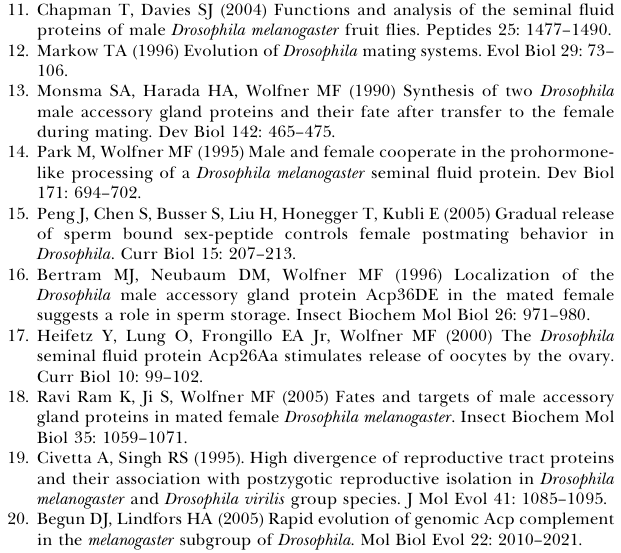
Figure S1. RT-PCR of (A) DmojGLEANR_8528, (B) Protease Gene Family 1, (C) Protease Gene Family 2, and (D) Protease Gene Family 3 One-kilobase markers are indicated. L, DNA ladder; N, negative control; M, whole male cDNA; C, female carcass (no lower reproductive tract) cDNA; R, lower female reproductive tract cDNA. Found at doi:10.1371/journal.pgen.0030148.sg001 (7.8 MB TIF). Table S1. D. arizonae Female Reproductive Tract ESTs D. mojavensis CDS: coding sequence from GLEANR annotations (http:// rana.lbl.gov/), D. melanogaster homolog identified by BLAST. SignalP: S, secreted; A, anchor; Q, quiescent as predicted by SignalP 3.0 [56]; TMHMM, number of identified transmembrane domains [57]; Ka, estimated nonsynonymous substitutions per nonsynonymous site; Ks, estimated synonymous substitutions per synonymous site; Ka/Ks, estimated ratio of nonsynonymous substitutions per nonsynonymous site to synonymous substitutions per synonymous site; PROT %ID, Protein % identity; CDS %ID, coding sequence % identity calculated in PAML [47]; Conserved domain, pfam conserved domain predicted from hmmpfam